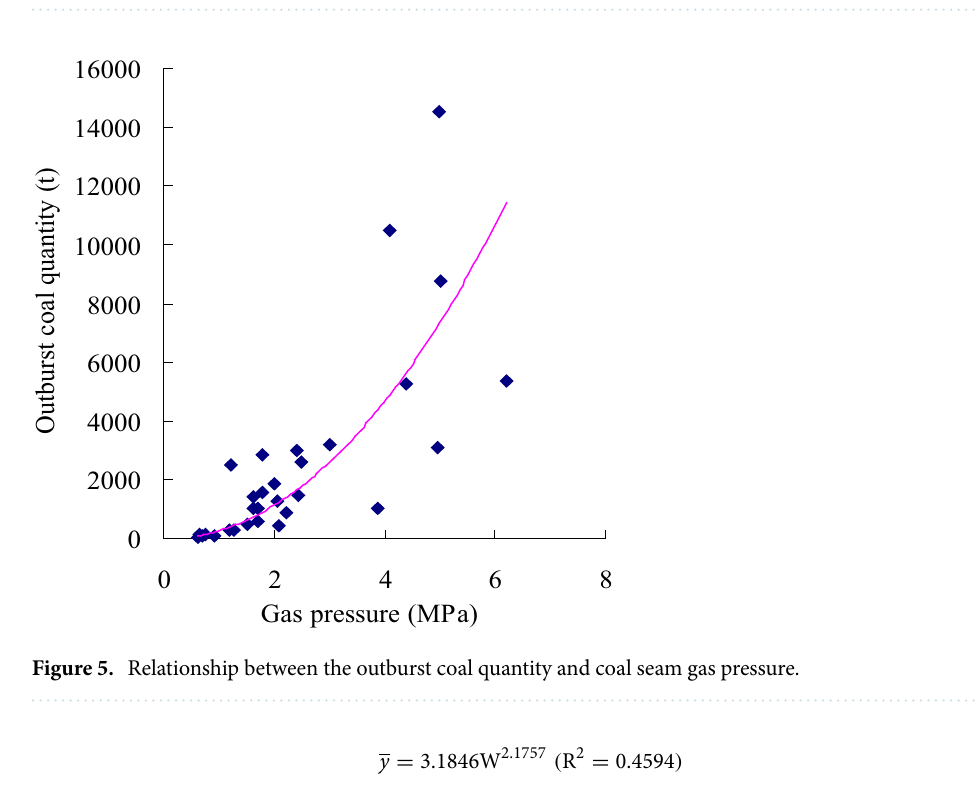
Figure 4. Relationship between the outburst coal quantity and coal seam gas content.